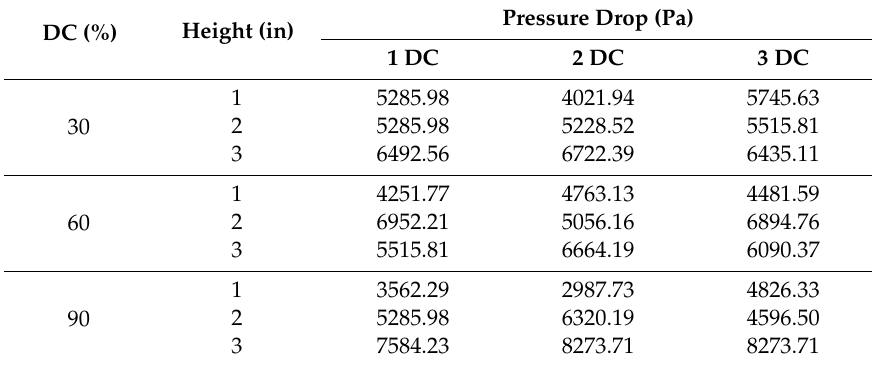
Figure 9. Flow resistivity test setup. Table 3. Observations of pressure drop results in Pa by the flow resistivity test.